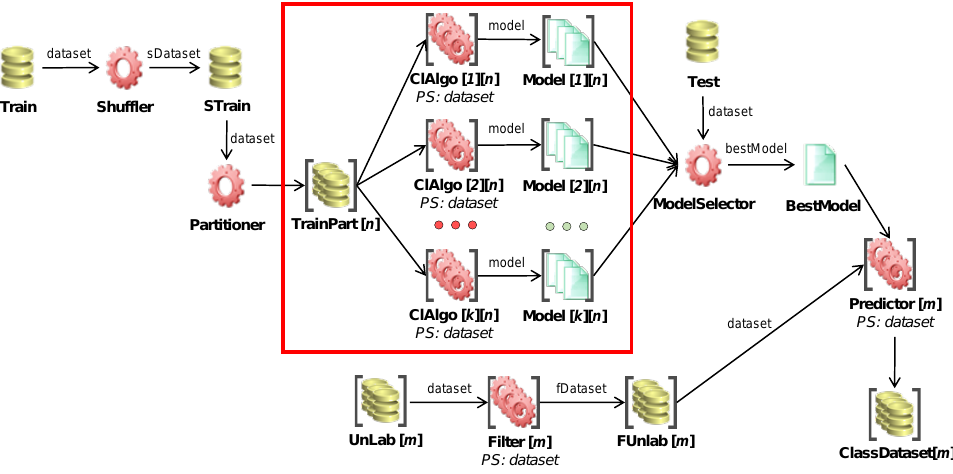
Figure 9. Ensemble learning workflow.